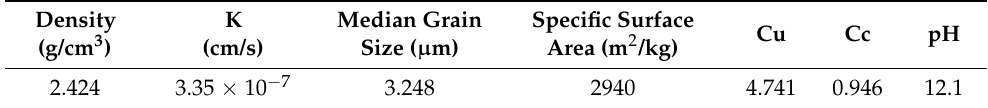
Figure 1. Physical and chemical properties of red mud: ( a ) particle size distribution of the red mud; ( b ) XRD of red mud. Table 1. Physical parameters of the red